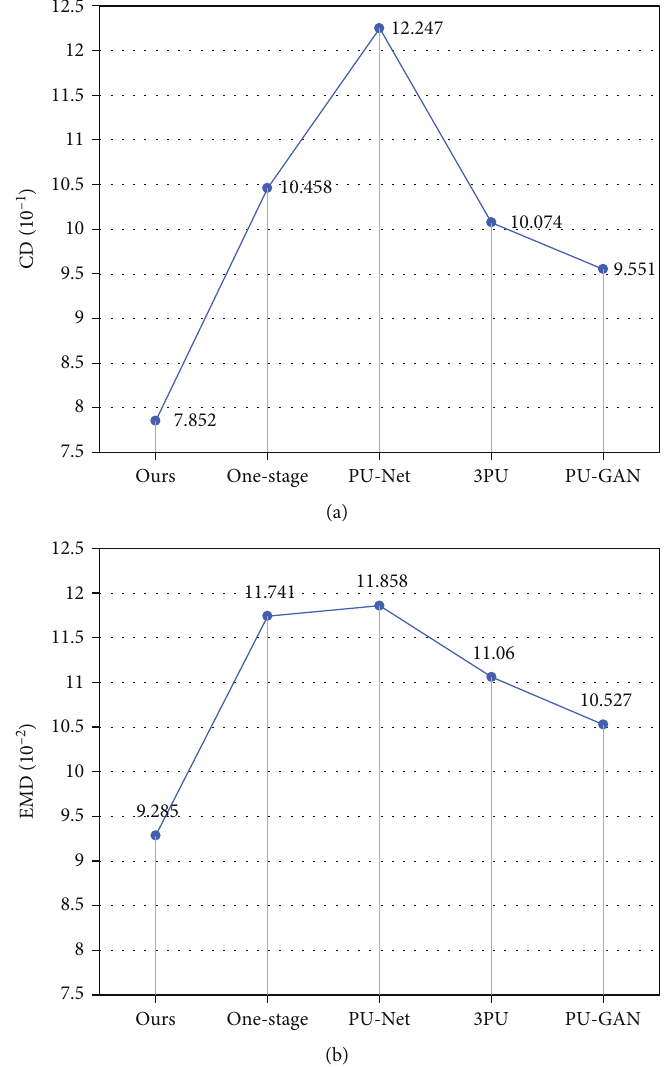
Figure 7: The e ff ect of di ff erent stage II generating